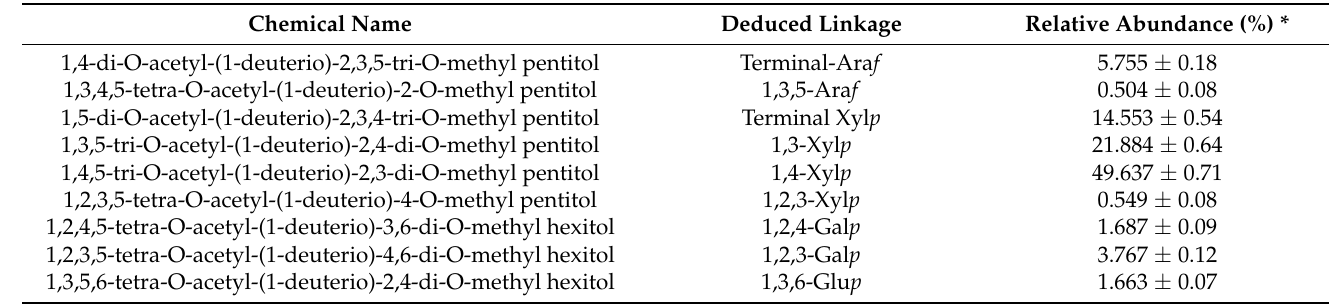
Table 1. Neutral sugar linkage composition (relative abundance %) of purified Yanang